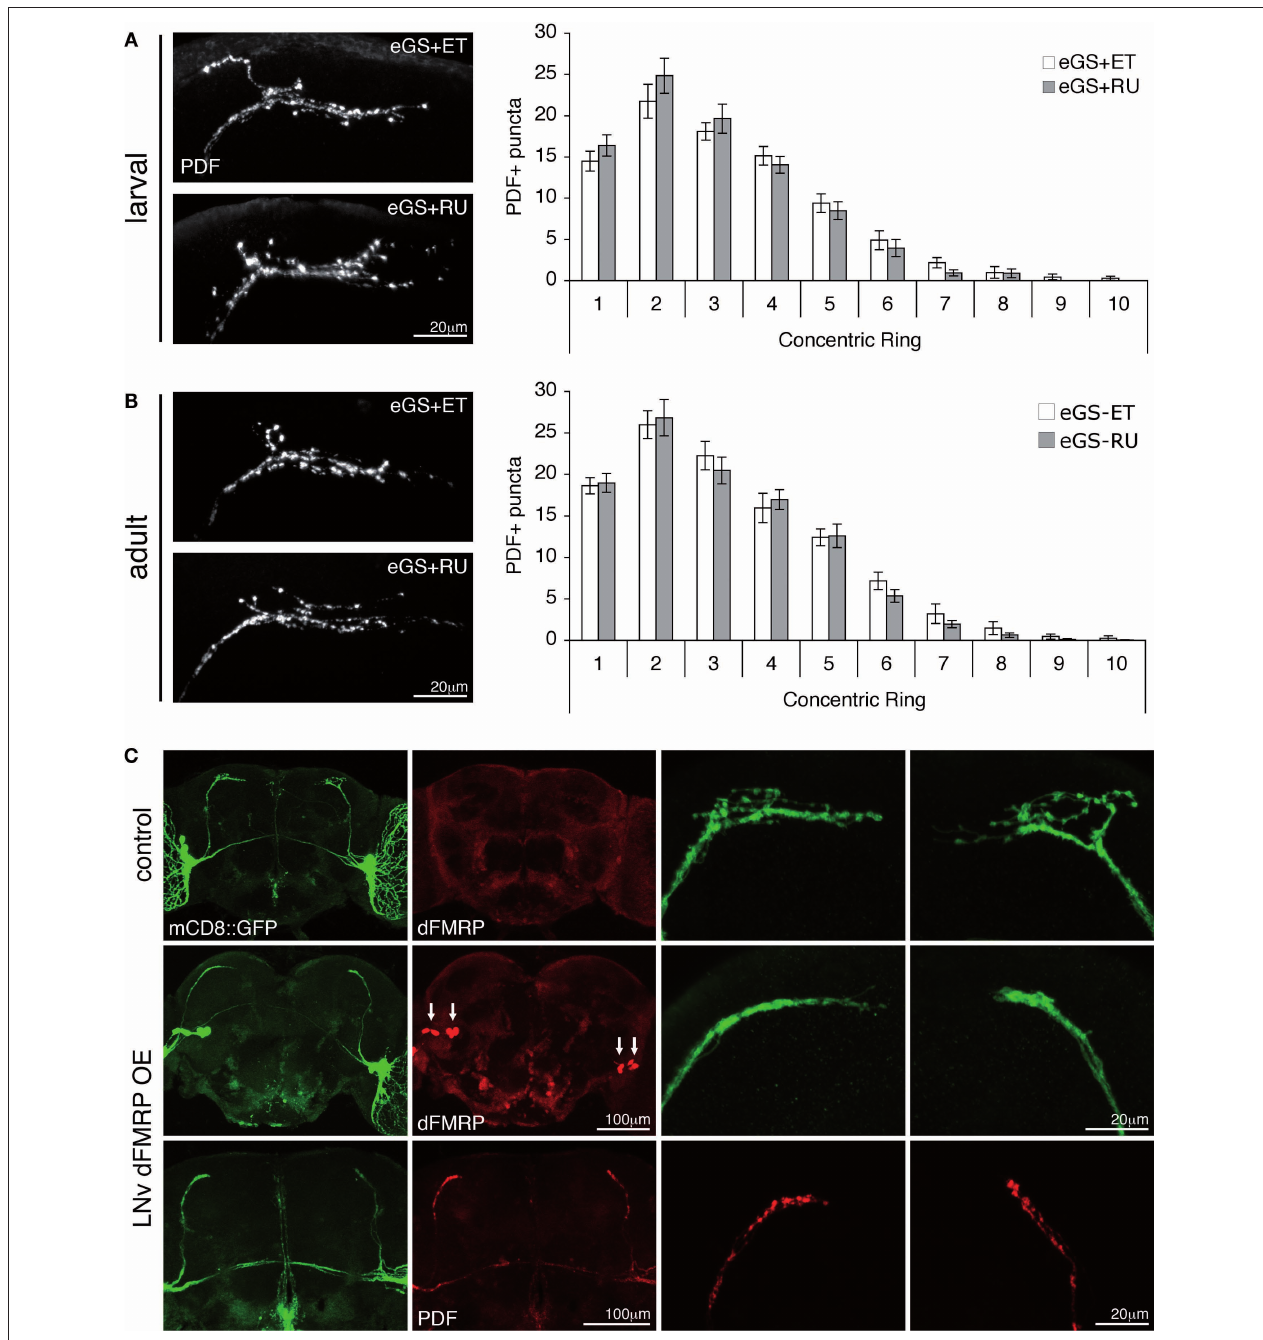
FIGURE 3 | dFMRP induction during early development and at maturity images of ventrolateral clock neurons expressing either UAS-mCD8::GFP provides no rescue of dfmr1 -null mutant sLN defects. (A) Comparison of (green) alone under the control of PDF-GAL4 (control: PDF-GAL4/UAS-mCD8:: v the dfmr1 -null eGS ethanol vehicle (eGS + ET) and RU486 (eGS + RU) treatment GFP) or in conjunction with, and thus overexpressing, UAS- dfmr1 (LNv dFMRP throughout larval development (instars L1–L3). At left, representative images OE: PDF-GAL4/UAS-mCD8::GFP; UAS-9557-3, dfmr1 50M / + ). Co-immunolabeling shown of adult sLN terminal arbors immunostained for PDF. At right, for dFMRP (red) illustrates endogenous (top row) and transgenic (middle row) v quantifi cation from the Sholl Analysis indicating no change with RU486 levels in the brain, and specifi cally in the sLN cell bodies (arrows). High v induction. (B) Analyses of adult-onset dFMRP induction. At left, representative magnifi cation views illustrate the sLN synaptic arbor collapse caused by v images shown from control and RU486-induced animals (treated d1–3) with cell-autonomous over-expression of dFMRP. Examination of collapsed arbors via synaptic arbors immunostained for PDF. At right, quantifi cation from the sLN co-immunolabelling for PDF (red, bottom row) revealed the persistence of v Sholl Analysis indicating no change with RU486 induction. (C) Representative PDF-positive presynaptic